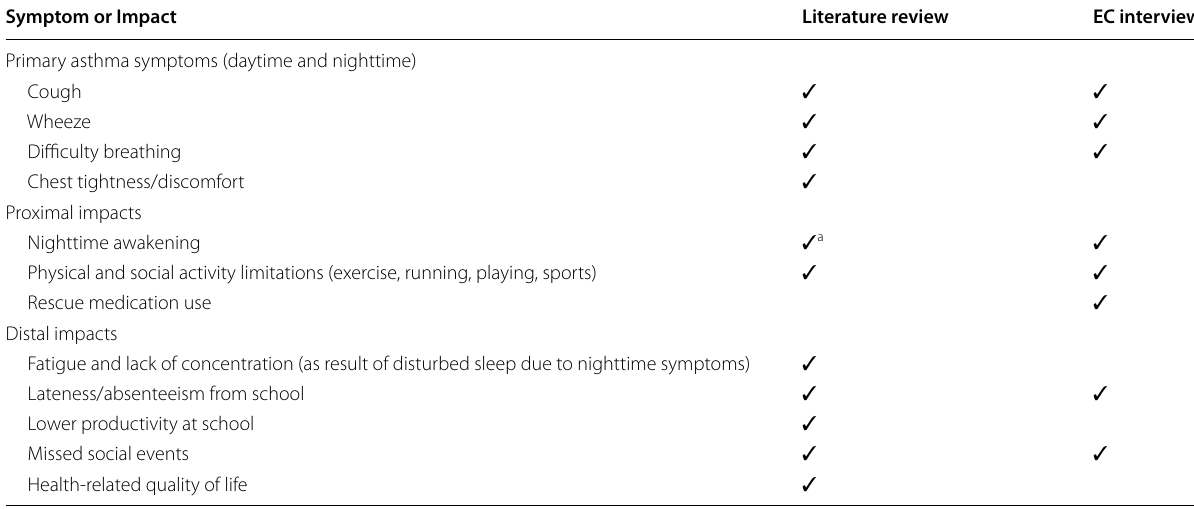
EC expert clinician a Nighttime awakening due primarily to cough and difficulty breathing were identified in the literature; nighttime awakening due to difficulty breathing, cough, and wheezing were primary symptoms reported by patients and/or caregivers to the expert clinicians interviewed